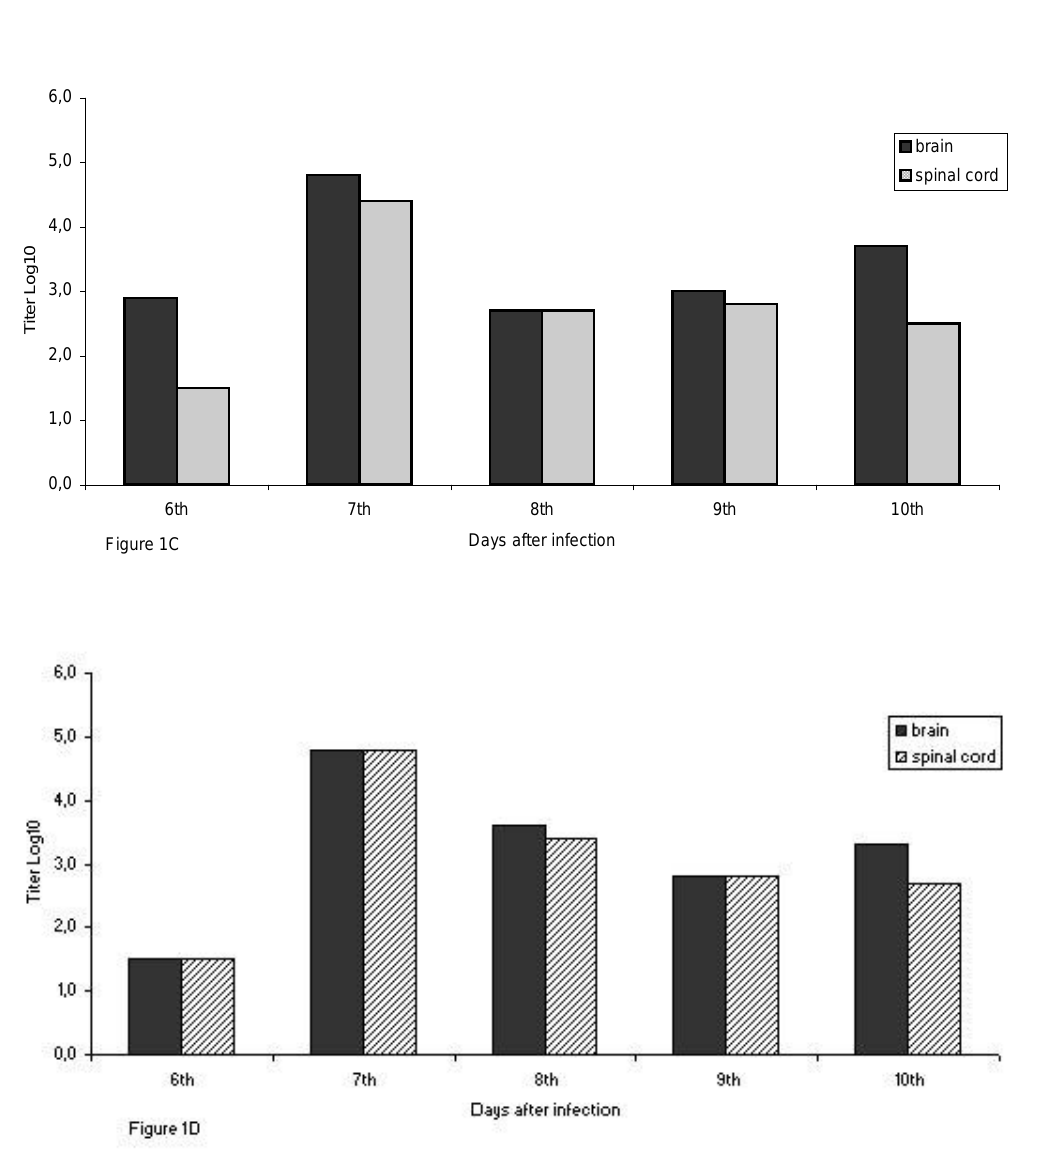
Figure 1: Kinetics of virus replication in the central nervous system (CNS) of mice selected for maximal and minimal acute inflammatory reaction (AIRmax and AIRmin) during infection by the rabies virus. Animals received intracerebral injections with 100 LD of PV1 43/4 and AgV3 strains. Brains and spinal cords were collected at 50 different times from animals showing rabies symptoms and the virus titer was detected using mouse inoculation